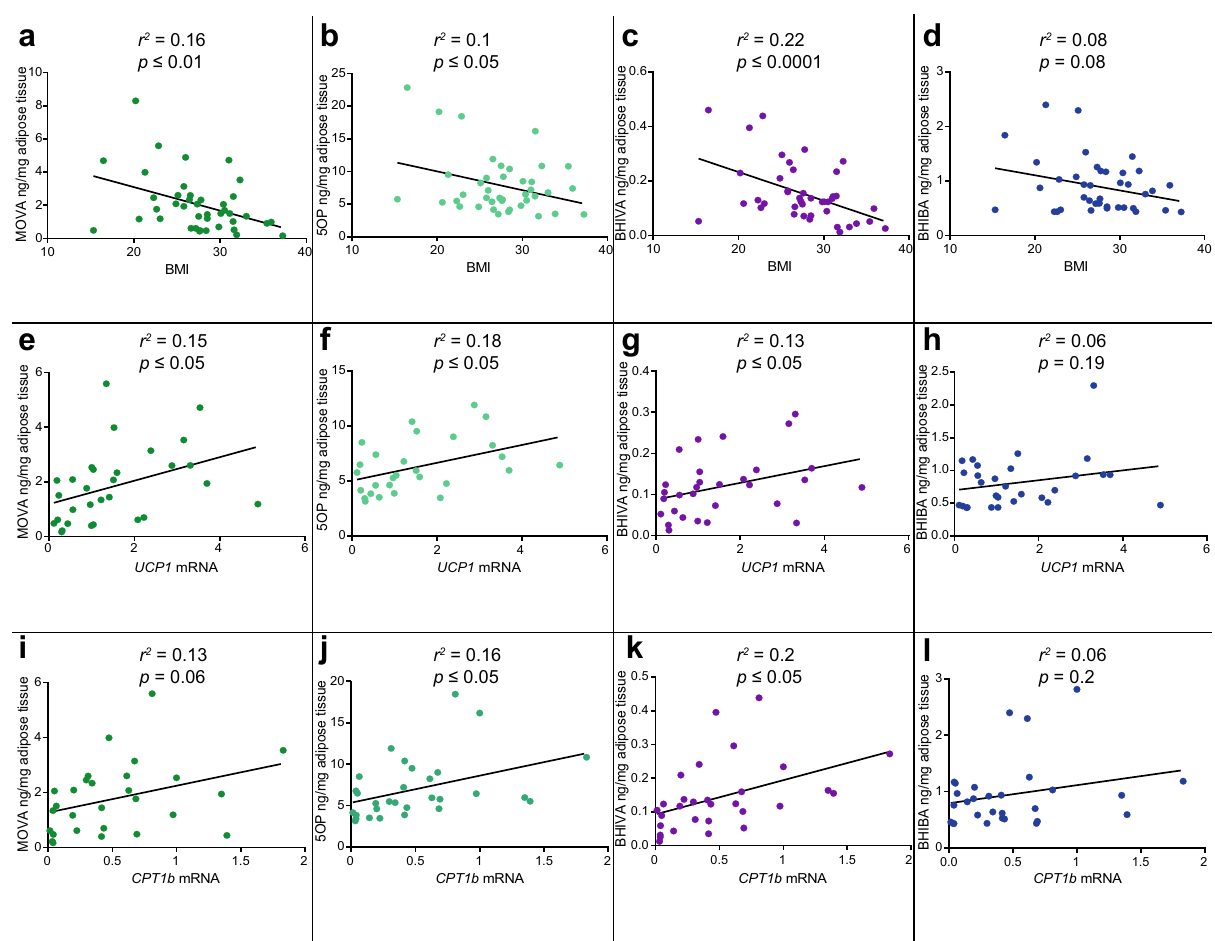
Fig. 6 The adipokine-like metabolite adipose tissue concentrations are inversely correlated with BMI and positively correlated with brown-adipocyte- associated gene expression in humans. a – d The inverse correlation of 3-methyl-2-oxovaleric acid (MOVA) ( n = 42, r 2 = 0.16, P = 0.0088), 5-oxoproline (5OP) ( n = 42, r 2 = 0.1, P = 0.046), β -hydroxyisovaleric acid (BHIVA) ( n = 42, r 2 = 0.345, P < 0.0001), and β -hydroxyisobutyric acid (BHIBA) ( n = 41, r 2 = 0.08, P = 0.08) subcutaneous adipose tissue concentration, measured by GC-MS, to BMI in human volunteers. e – h Correlation of MOVA ( n = 30, r 2 = 0.15, P = 0.032), 5OP ( n = 30, r 2 = 0.18, P = 0.02), BHIVA ( n = 30, r 2 = 0.13, P = 0.05), and BHIBA ( n = 29, r 2 = 0.06, P = 0.19) concentration with uncoupling protein 1 ( UCP1 ) gene expression in subcutaneous adipose tissue of human volunteers. i – l Correlation of MOVA ( n = 28, r 2 = 0.13, P = 0.06), 5OP ( n = 30, r 2 = 0.164, P = 0.027), BHIVA ( n = 30, r 2 = 0.2, P = 0.014), and BHIBA ( n = 29, r 2 = 0.06, P = 0.2) concentration with carnitine palmitoyltransferase 1b ( CPT1b ) gene expression in human adipose tissue. Dark green = MOVA, light green = 5OP, purple = BHIVA, dark blue = BHIBA. Analysis by Pearson correlation. Source data are provided as a Source Data fi